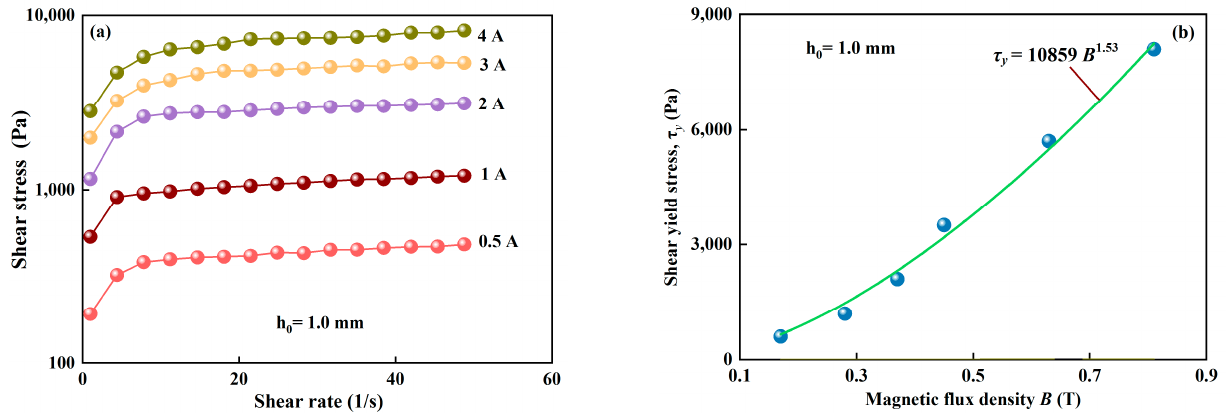
Figure 3. Mechanical properties of the MR fluid under shearing. ( a ) Shearing curves of shear stress versus shear rate at different applied currents in a range from 0.5–4A, corresponding to 0.17–0.81 T; ( b ) the shear yield stress versus magnetic fields.